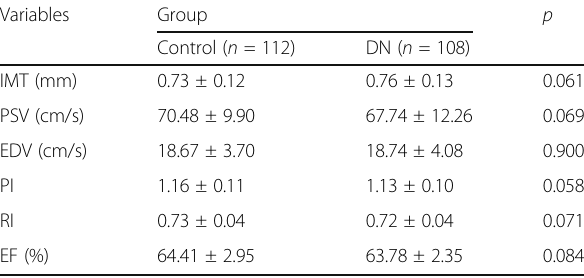
Table 2 Comparison of conventional ultrasound parameters Variables